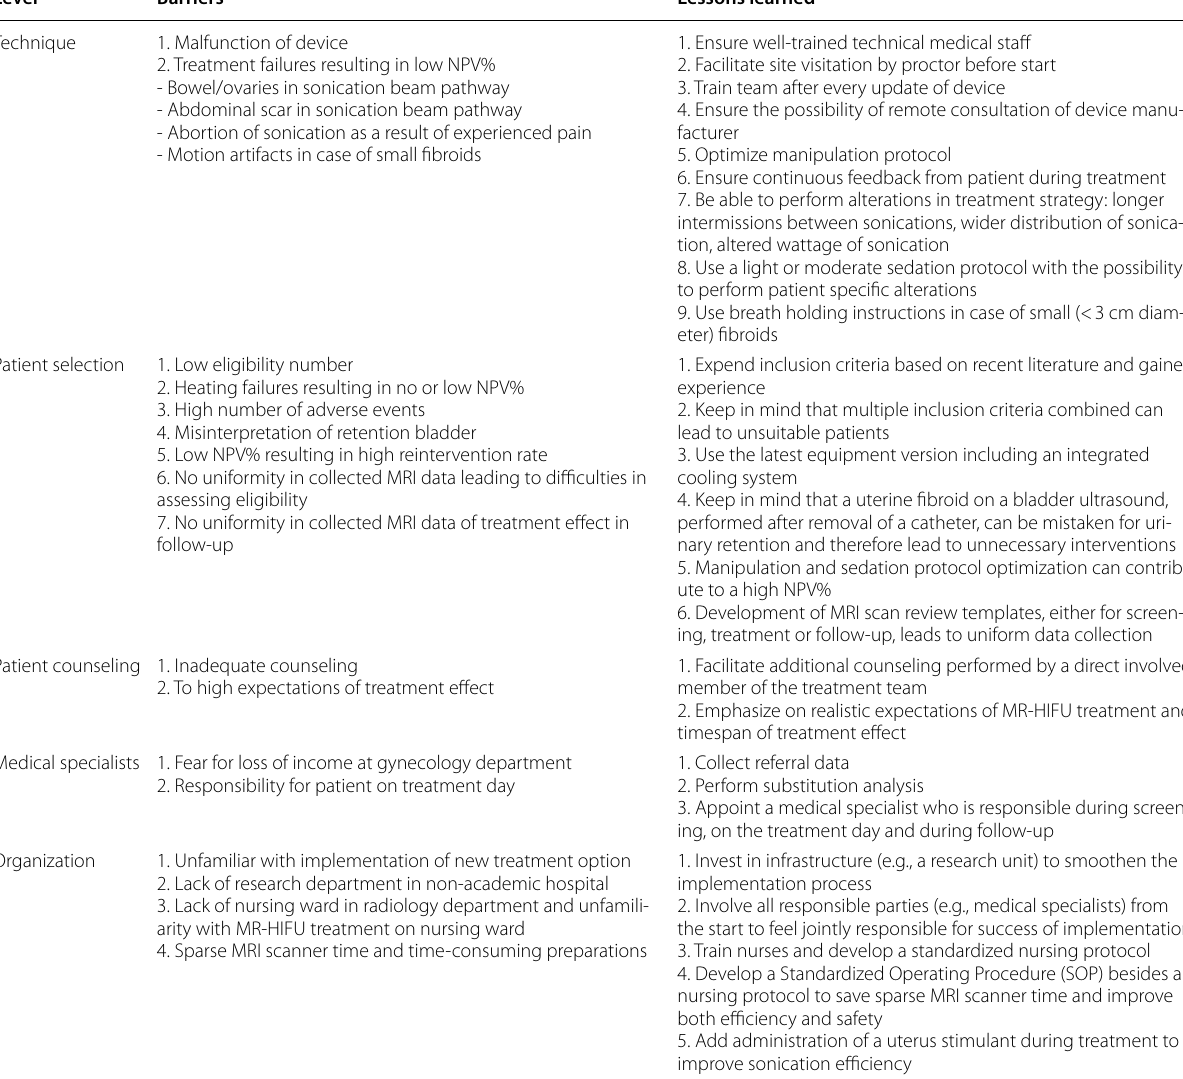
Table 6 Different identified barriers and lessons learned on technical, patient selection, patient counseling, medical specialist and organizational